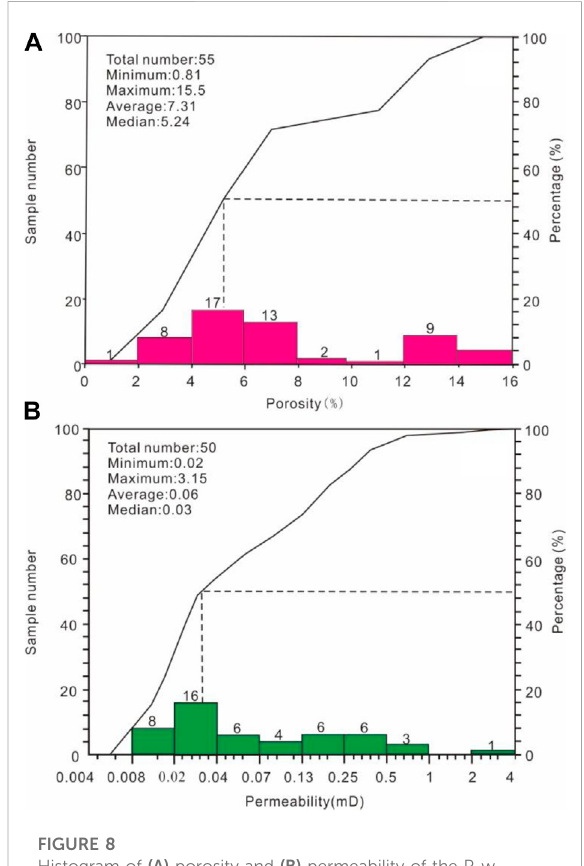
FIGURE 8 Histogram of (A) porosity and (B) permeability of the P 3 w reservoir in Fukang